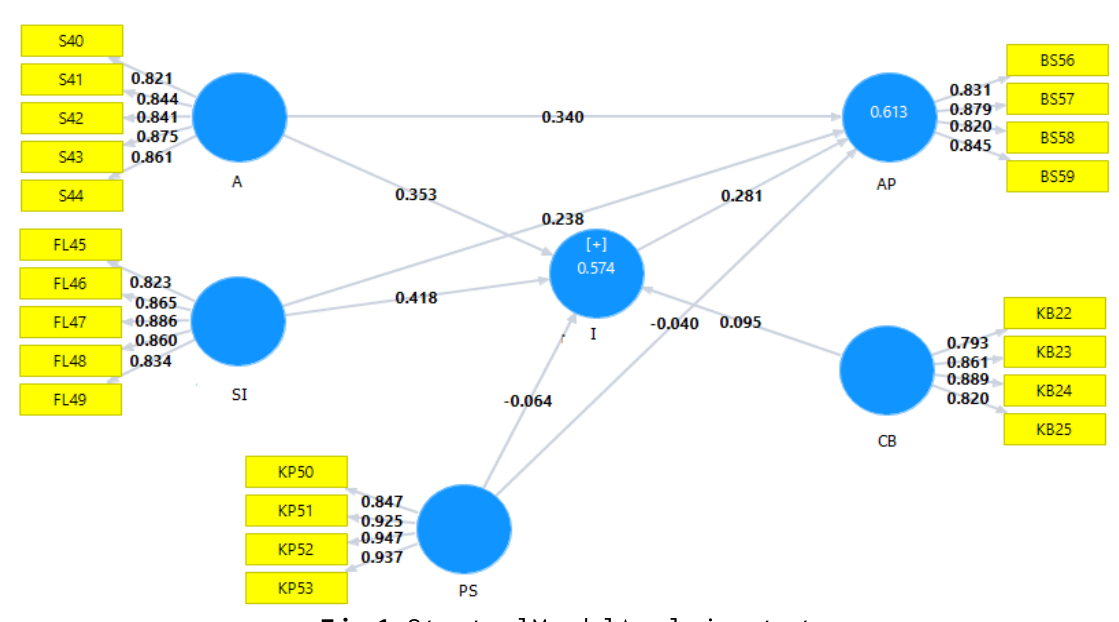
Fig. 1. Structural Model Analysis